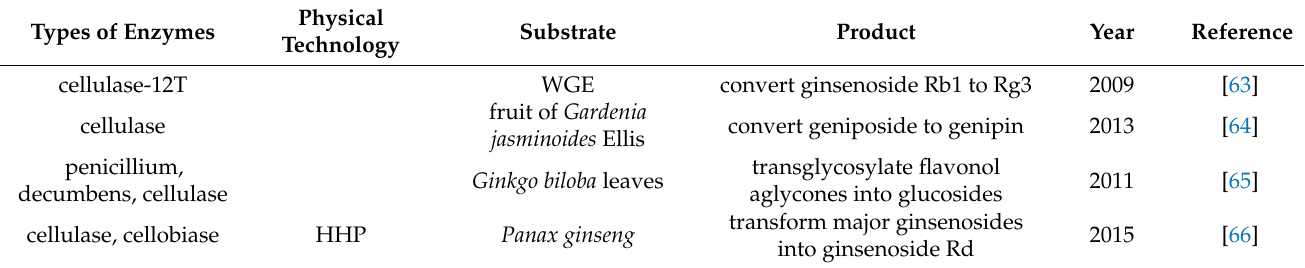
Table 4. Structural modification of bioactive components by cellulase during extraction. Types of